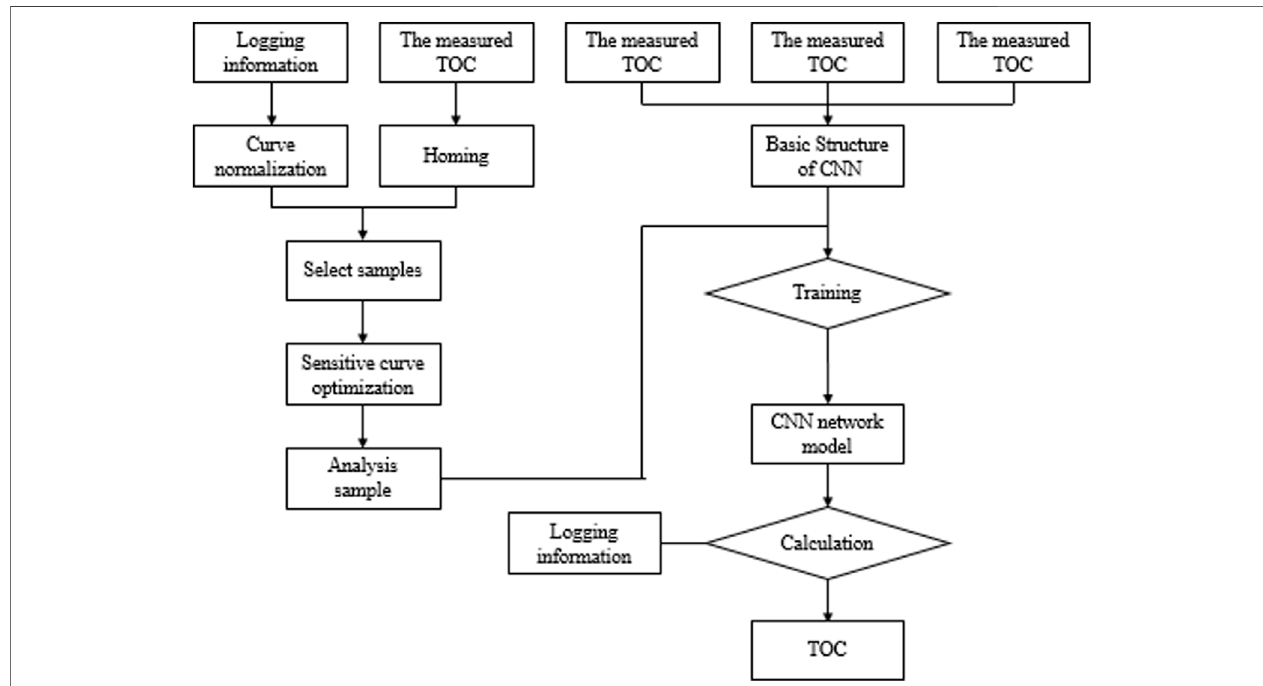
FIGURE 7 | CNN-based complex lithology TOC logging calculation